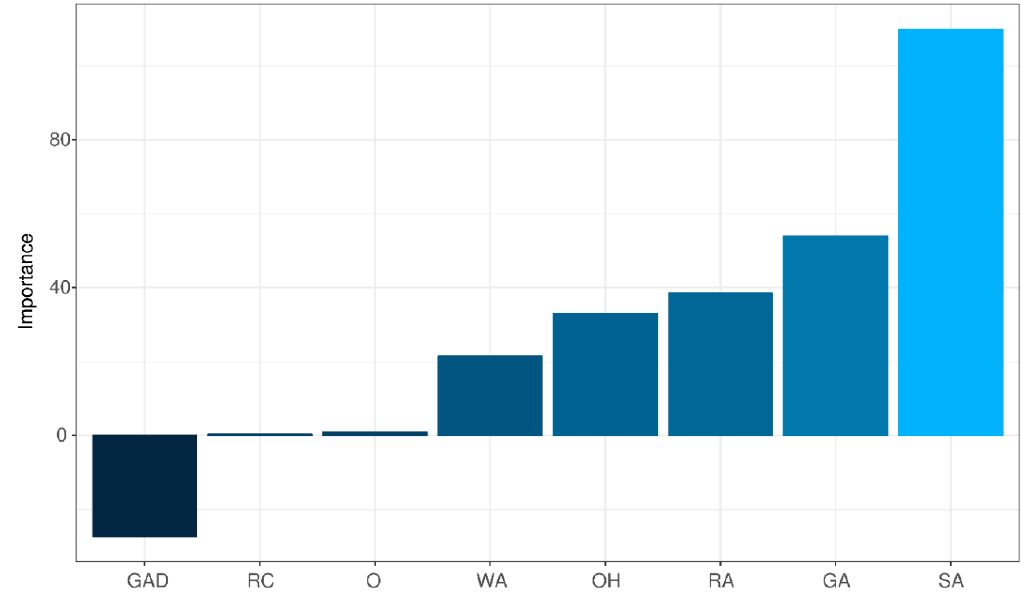
Figure 22. Importance level of the input variables for predicting the HL of EEB systems.